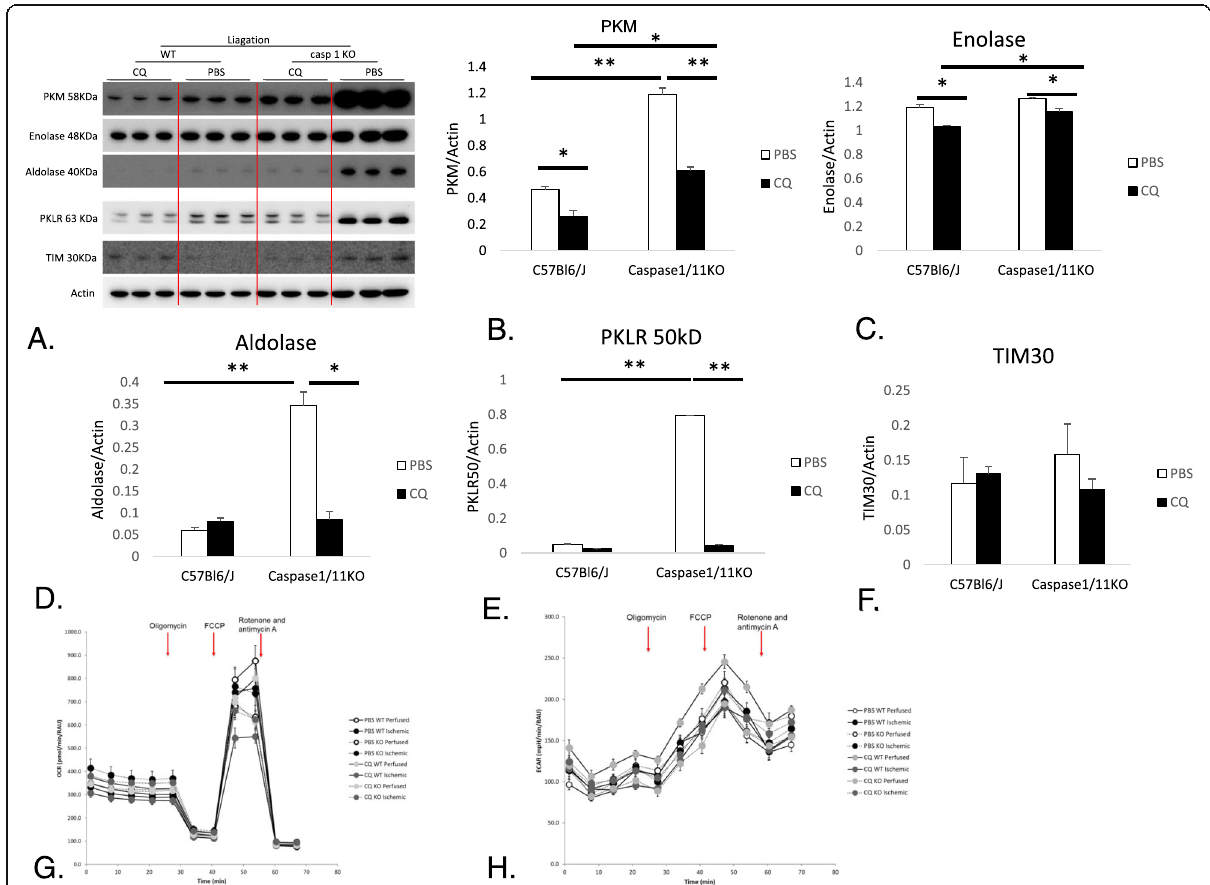
Fig. 10 Glycolysis enzyme levels are elevated in caspase-1/11KO. a Western blot images of expression of Protein Kinase M (PKM), enolase, aldolase, Protein Kinase L/R (PKLR), TIM30 and actin loading control in muscle stellate cells (MuSC) at 5 days after harvest from tibialis anterior (TA) nonischemic and ischemic muscle at 21 days after femoral artery ligation (FAL) in C57Bl/6 J (WT) and caspase-1/11KO mice treated with PBS or CQ (50 mg/kg) ( b - f ) Quantification of relative expression of each enzyme relative to actin using Image J gel analyzer was used to quantify relative expression to that of actin loading control; ( b ) PKM * p < 0.03 PBS:CQ WT and CQ in WT:KO, ** p < 0.001 PBS in WT:KO and PBS:CQ KO; ( c ) enolase * p < 0.03 PBS: CQ in WT and KO and CQ in WT:KO; ( d ) PKLR ** p < 0.001 PBS:CQ in KO and PBS in WT:KO; ( e ) aldolase * p < 0.03 PBS:CQ in KO, ** p < 0.001 PBS in WT:CQ; ( f ) TIM30; ( g ) oxygen consumption rate (OCR) and ( h ) extracellular acidification rate (ECAR) measured by